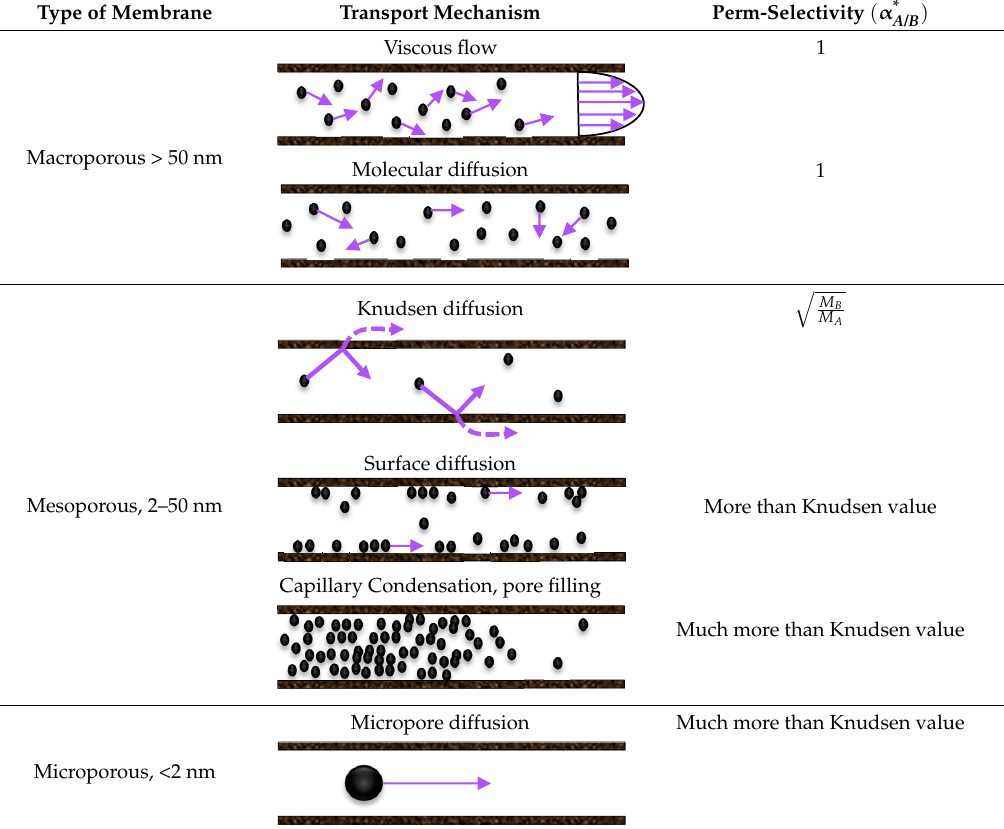
Table 2. Gas transport mechanism inside porous materials and their perm-selectivity.